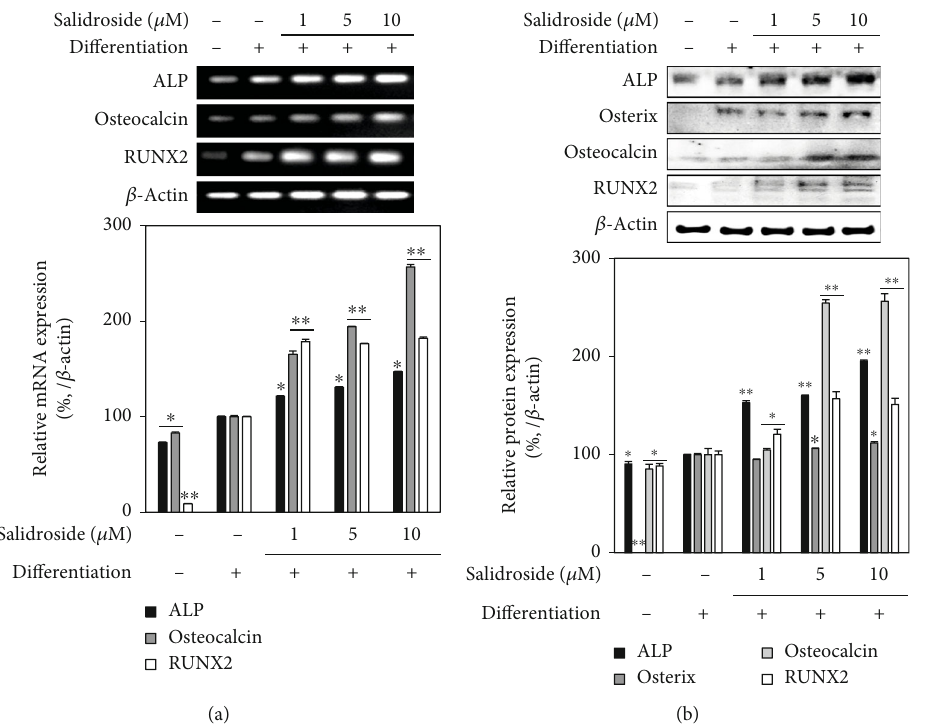
Figure 7: E ff ect of salidroside on (a) mRNA and (b) protein expression of osteogenic markers. Analysis of mRNA and protein levels was carried out by RT-PCR and Western blotting, respectively, using the osteo-induced hBM-MSC lysates. PCR and protein bands were densitometrically quanti fi ed and plotted as relative percentage of the untreated di ff erentiated control group. β -Actin was used as internal loading control. ∗ p < 0 : 05 and ∗∗ p < 0 : 01 vs. the untreated di ff erentiated control